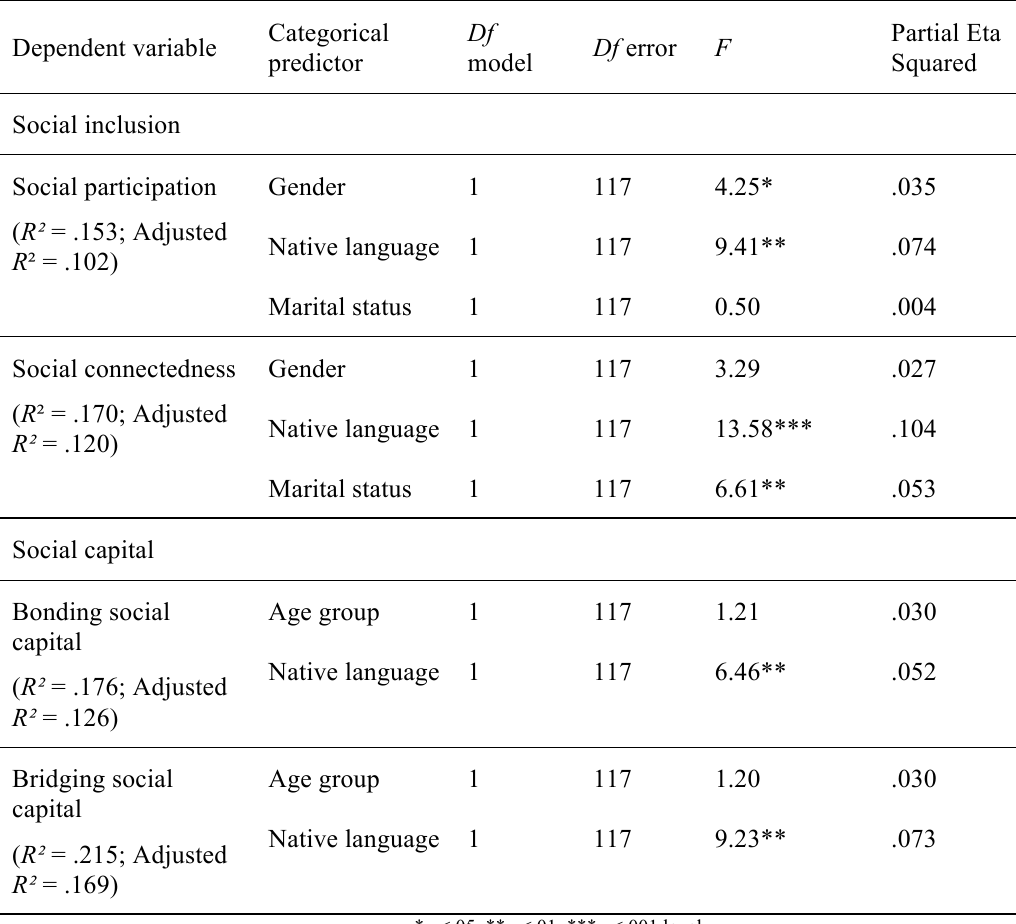
Table 8 : Results of univariate ANOVA’s among blended adult